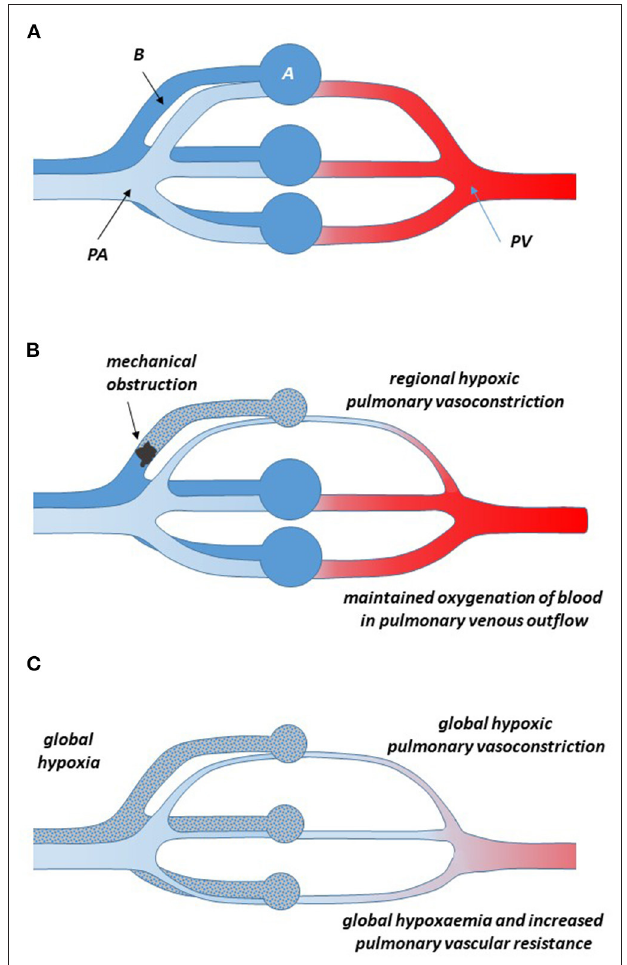
FIGURE 2 | Schematic representation of the pulmonary circulation in normoxia (A) and when one bronchus is obstructed and the respective alveoli are hypoventilated (B) . During normoxia in the healthy state, deoxygenated blood from the pulmonary artery flows through the capillary bed surrounding the alveoli, where it takes up oxygen and, fully oxygenated, returns through the pulmonary vein to the left atrium of the heart. Local hypoventilation of an area of the lungs causes vasoconstriction of the pulmonary arteries in the same area; thus, less blood flows through the hypoventilated area and relatively more through other, better ventilated areas, resulting in a minimal reduction of the oxygenation status of the blood returning into the systemic circulation through the pulmonary vein (Euler-Liljestrand mechanism). (C) In global hypoxia, hypoxic pulmonary vasoconstriction occurs throughout the lung. This obviously does not improve the oxygenation status of the blood, but it causes a major increase in total pulmonary vascular resistance. When this situation is maintained for longer time periods, pulmonary hypertension may occur, resulting in right ventricular hypertrophy and